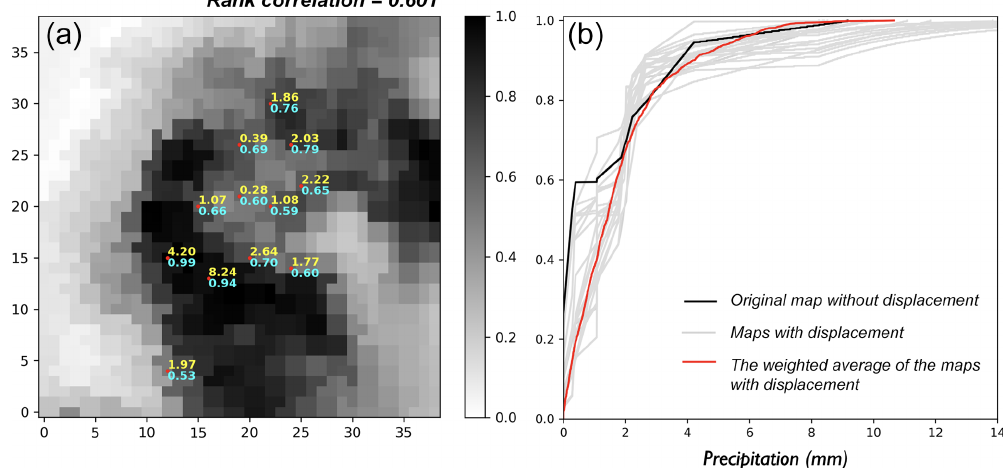
Figure 3. (a) Original radar quantile map (–) for the 30min event (4 May 2017, 13:20–13:50LT), with the rain gauge observations (mm) labeled in yellow and the collocated radar quantiles labeled in cyan. (b) Distribution functions of surface rainfall. Black: original radar map without displacement; gray: radar maps with displacement; red: the weighted average of the radar maps with